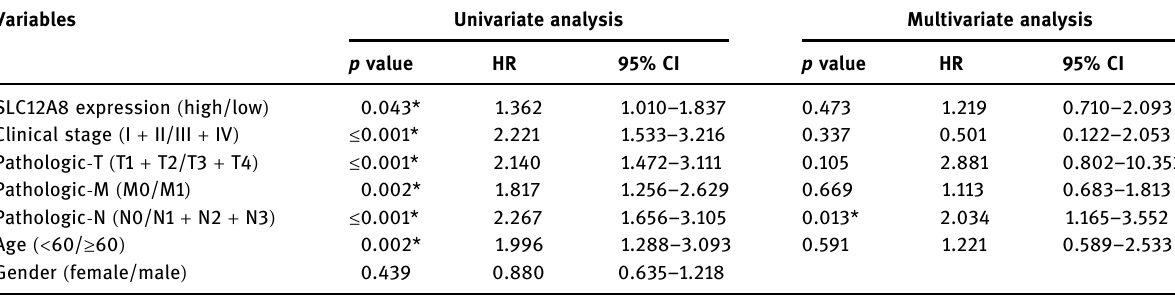
Table 2: COX regression analysis of univariate and multivariate factor of bladder cancer